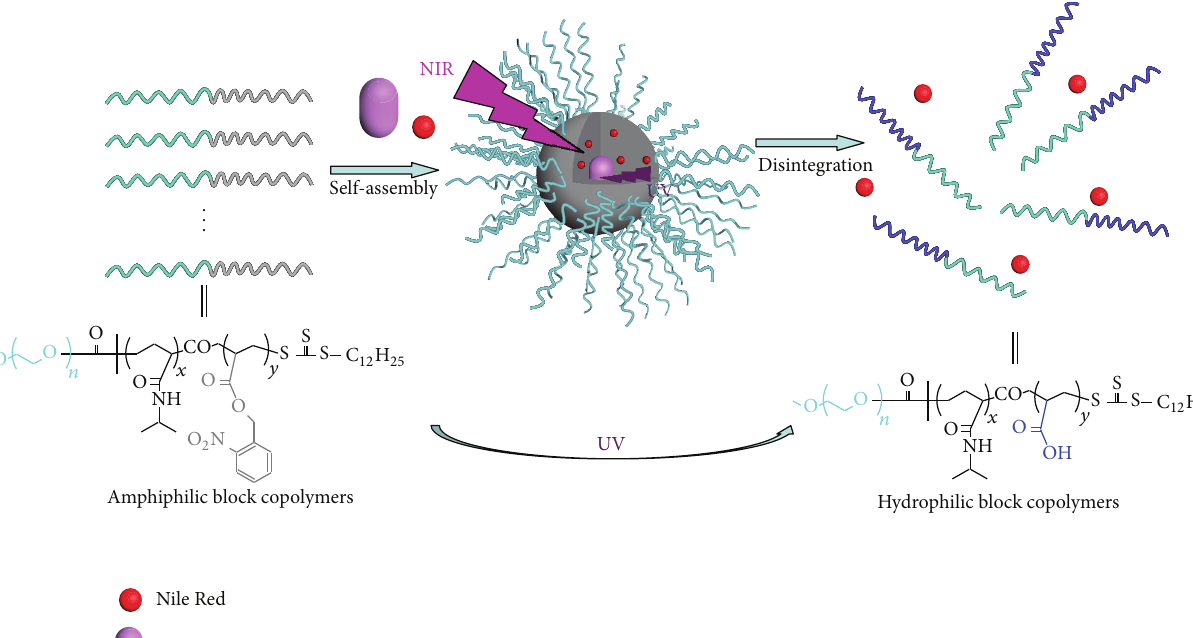
Scheme 1: Schematic illustration for fabrication of the core-shell hybrid nanoparticle and NIR triggered release of the loaded model drugs (Nile